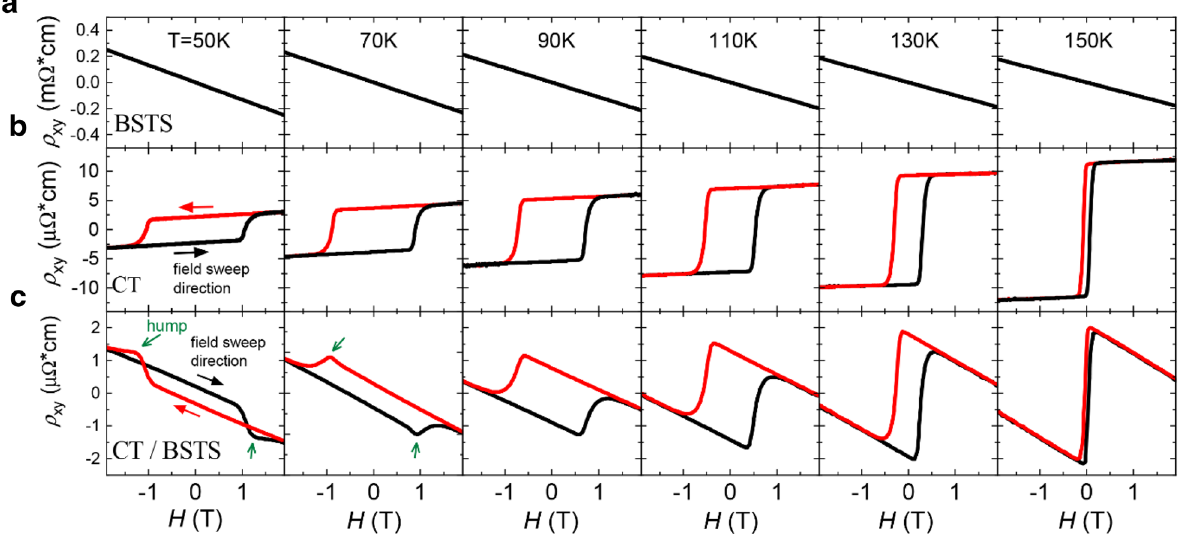
Fig. 2 The evolution of Hall resistivity trace ( R xy ( H ) ) of a CT/BSTS heterostructure. a , b , c The Hall resistivity as a function of the magnetic field of BSTS ( a ), CT ( b ), and CT/BSTS ( c ), respectively. The black and red curves represent the cases for ascending and descending magnetic field sweeps as indicated by black and red arrows, respectively. The appearance of the hump structure is highlighted by the green arrows in ( c ). The measurement temperatures (50 – 150 K) are indicated at ( a